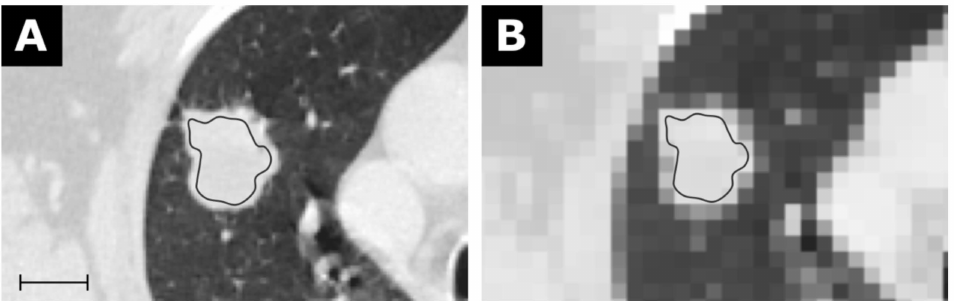
Figure 4. CT of a bronchial carcinoma ( A ) with a corresponding map for the feature Mean with a resolution of 5 × 5 × 5 mm in ( B ). Scale indicates 2 cm. The value for Mean from the conventional extraction was 24.9 and 22.2 for the map. Details are available in electronic Table S2.